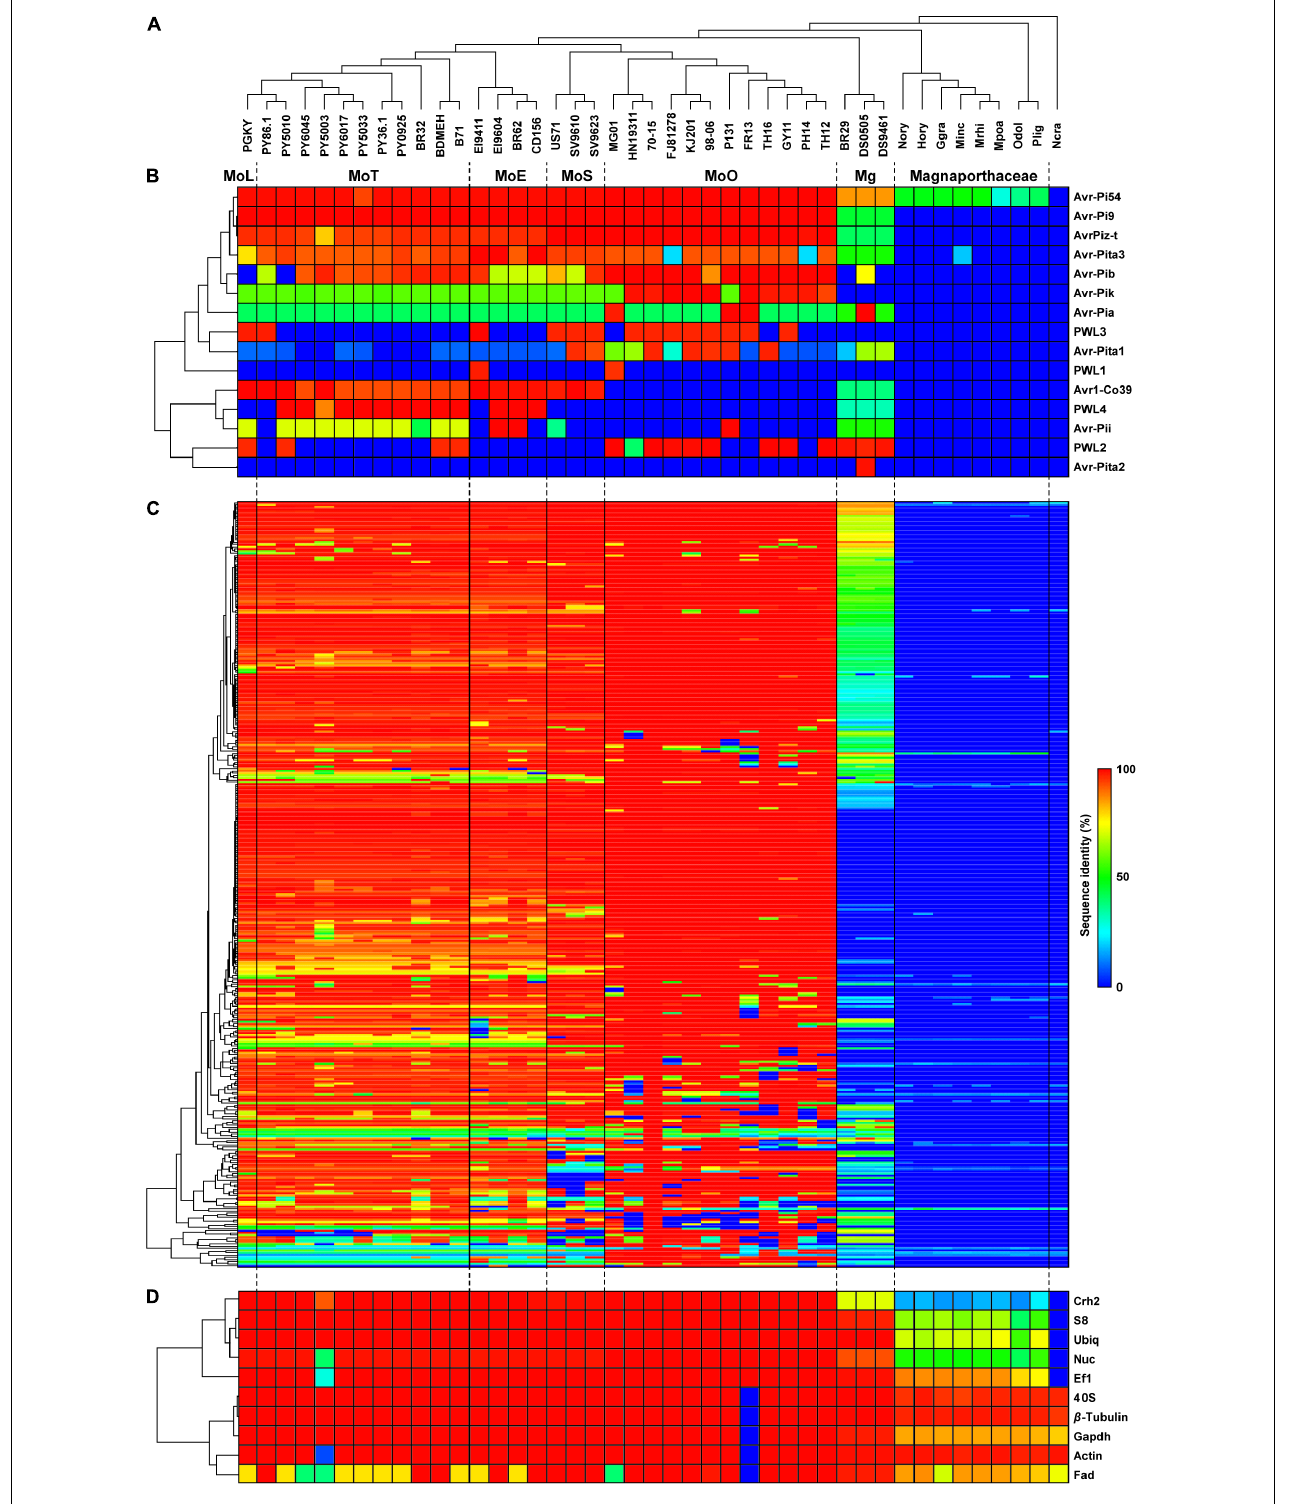
FIGURE 1 | Distribution patterns of the AVR and EFC proteins encoded by M. oryzae , M. grisea and other Magnaporthaceae species. (A) A phylogenomic tree of the isolates/species analyzed in this study was constructed using 2,245 SCO gene products. The pathotype of each M. oryzae isolate is abbreviated according to the host of origin: Lolium (MoL), Triticum (MoT), Eleusine (MoE), Setaria (MoS), and Oryza (MoO). Isolates of M. grisea from Digitaria are designated as Mg.